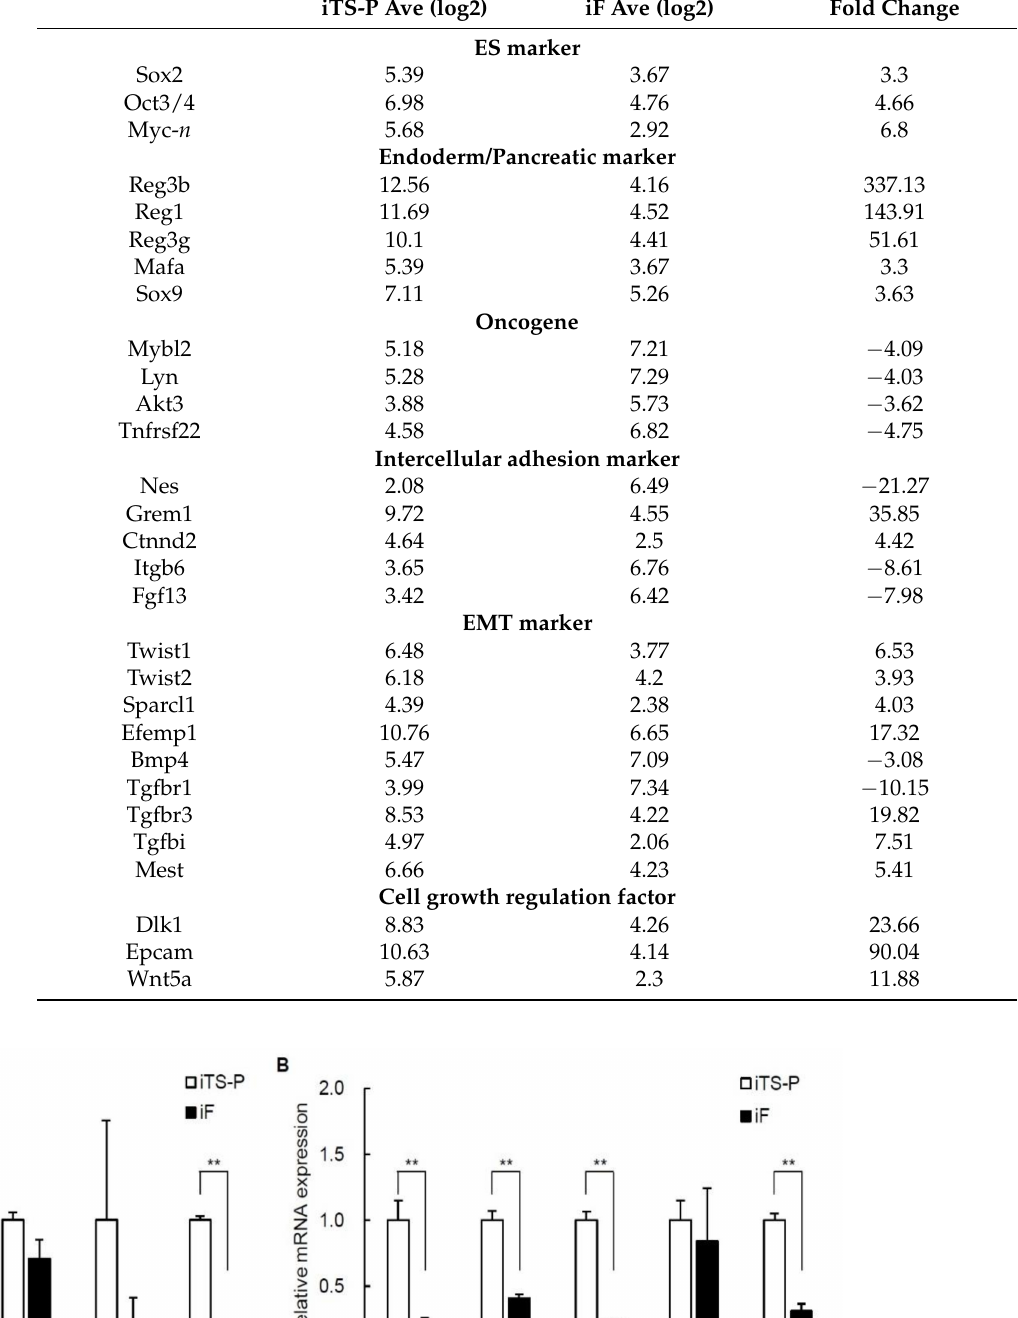
Table 1. Twenty-nine ES marker, endoderm/pancreatic marker, oncogenic, intercellular adhesion marker, EMT marker, and cell growth regulatory factor genes whose expression levels differed by >3-fold between iF cells and iTS-P cells.